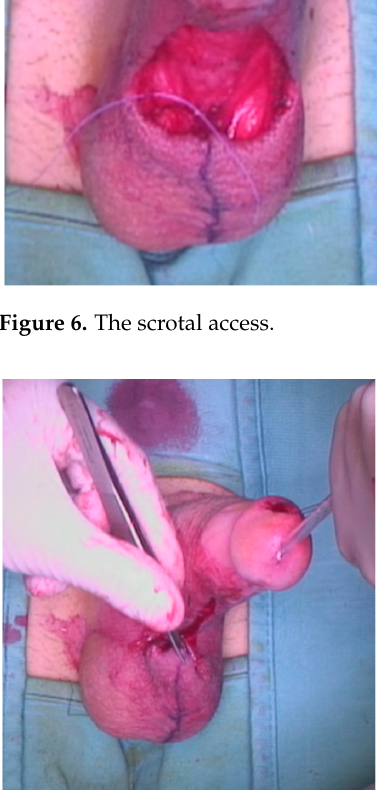
Figure 7. a V-Y scrotoplasty was performed.